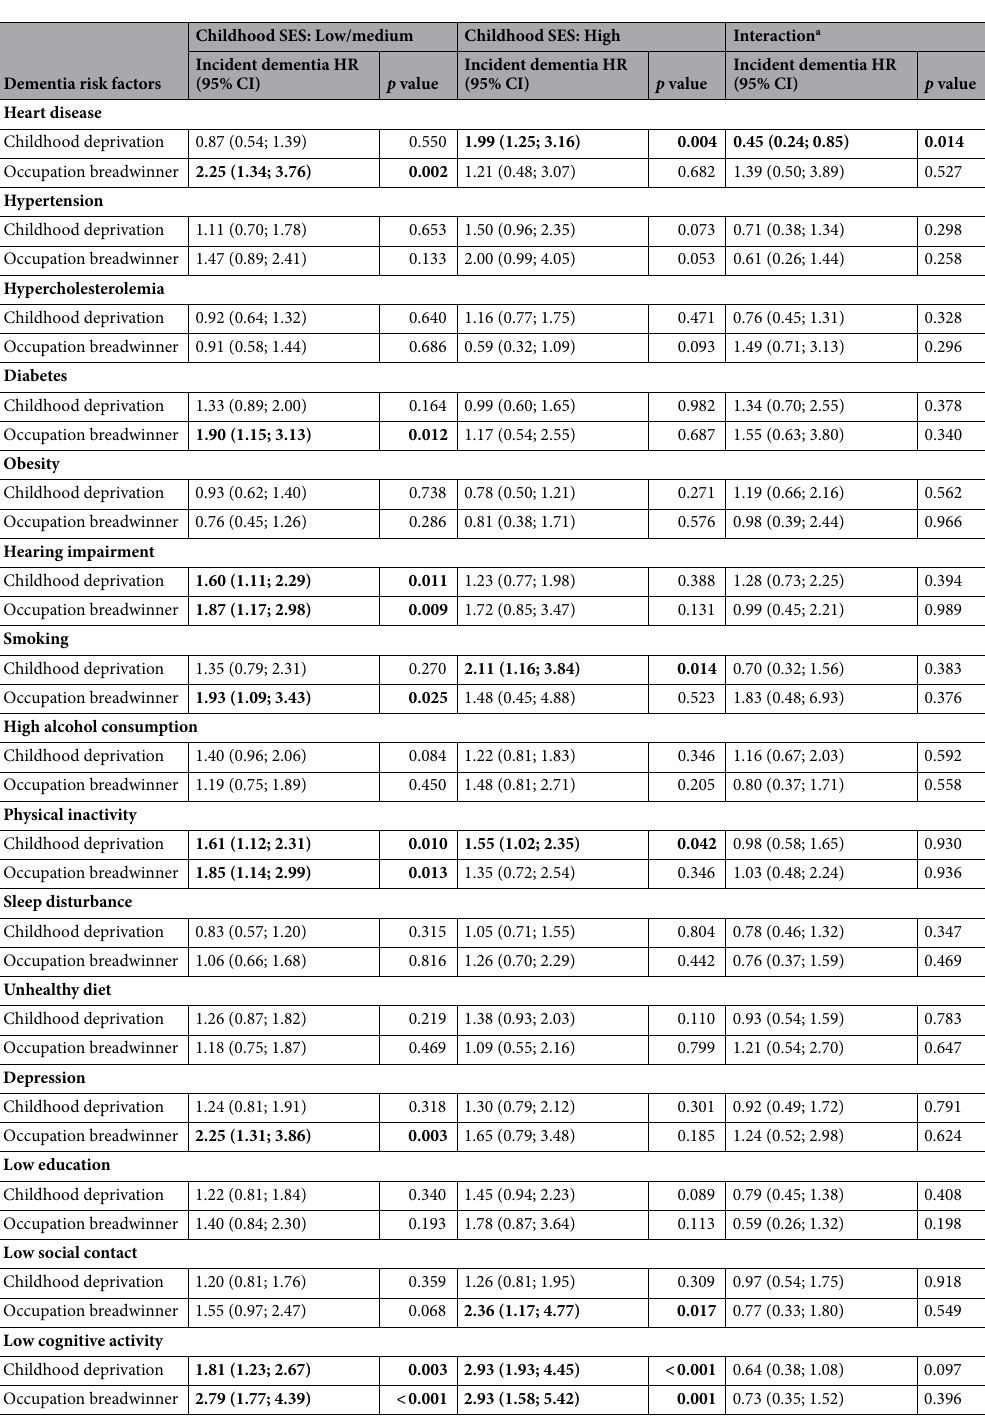
Table 3. The association of dementia risk factors with incident dementia stratified by indicators of childhood socioeconomic status (childhood deprivation yes and no; occupation breadwinner low/medium and high) and the interactions of the dementia risk factors with childhood socioeconomic status on dementia risk. Childhood deprivation n = 2325 (135 dementia cases) and no childhood deprivation n = 3313 (117 dementia cases). Low/ medium occupation breadwinner n = 2642 (91 dementia cases) and high occupation breadwinner n = 1545 (45 dementia cases). SES socioeconomic status; HR hazard ratio; CI confidence interval. Analyses are adjusted for age, sex/gender, and clustering at the household level. a The interaction of the risk factors with childhood SES on incident dementia with high childhood SES as the reference category. Significant values are in